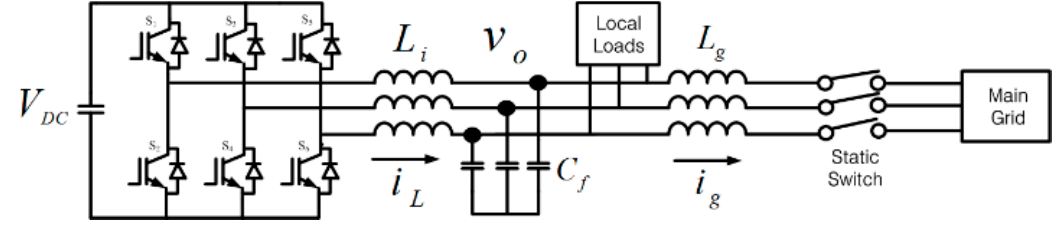
Figure 1. System configuration of grid-connected inverter with LCL filter and local loads.